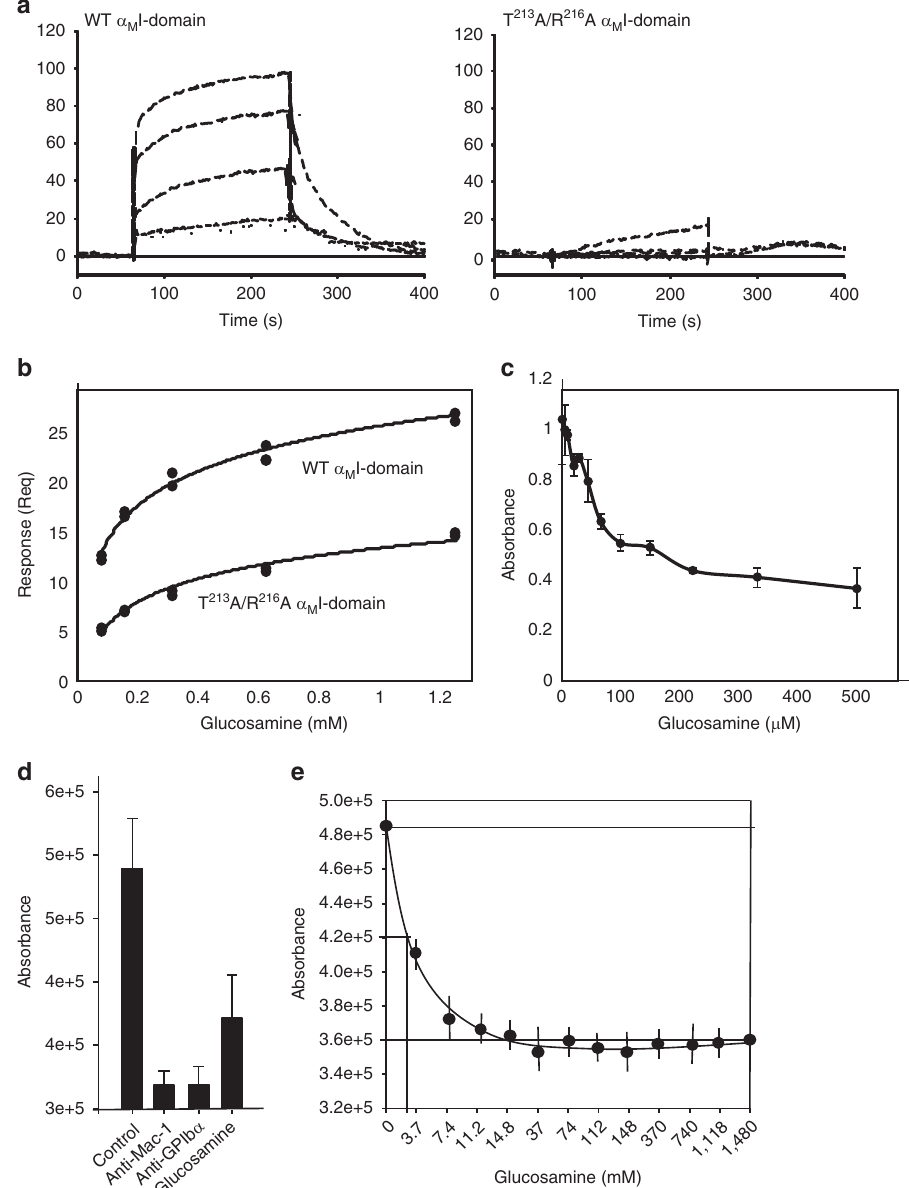
Figure 8 | Glucosamine binds to the a M I-domain of Mac-1 and inhibits Mac-1 and GPIb a binding. ( a ) Binding of glucosamine to human WTand mutant (T 213 A/R 216 A) a M I-domain was assessed in real time by SPR. The a M I-domains were immobilized on CM5 biosensor chips at B 2,500 RU, and SPR sensograms were obtained by injecting various concentrations of glucosamine over the immobilized a M I-domain proteins. ( b ) Steady-state binding isotherms for human WT and mutant (T 213 A/R 216 A) a M I-domain. Responses at the end of the association phase (Req) were used to determine K 0.5 by fitting the curves to a steady-state affinity model (response units versus concentration). For this set of experiments, the a M I-domains were immobilized at B 6,000 RU (in contrast to a ). ( c ) The effect of glucosamine on binding of a M I-domain to purified GPIb a . Wells of Costar 96-well plates were coated with 1 m M GPIb a , post-coated with 0.5% PVP and 1 m M GST-tagged a M I-domain was added in the presence of glucosamine, 4–500 m M. After 15min in room temperature, plates were washed and bound I-domain was quantified using anti-GST pAb and horseradish peroxidase (HRP)/3,3 0 ,5,5 0 - tetramethylbenzidine system. Absorbance was read at 450nm. ( d ) The effect of glucosamine on Mac-1:GPIb a binding was investigated using a cell-binding assay with Mac-1-transfected 293 and GPIb ab -transfected CHO cells. Binding of transfected cells in presence of anti-Mac-1 (ICRF44), anti-GPIb a (VM16d) or glucosamine (50 m M). ( e ) Dose-dependent inhibition of Mac-1 293 cells binding to GPIb ab -transfected CHO cells by glucosamine. Data are mean ± s.d. (error bars) from two to three independent experiments with each experiment performed in